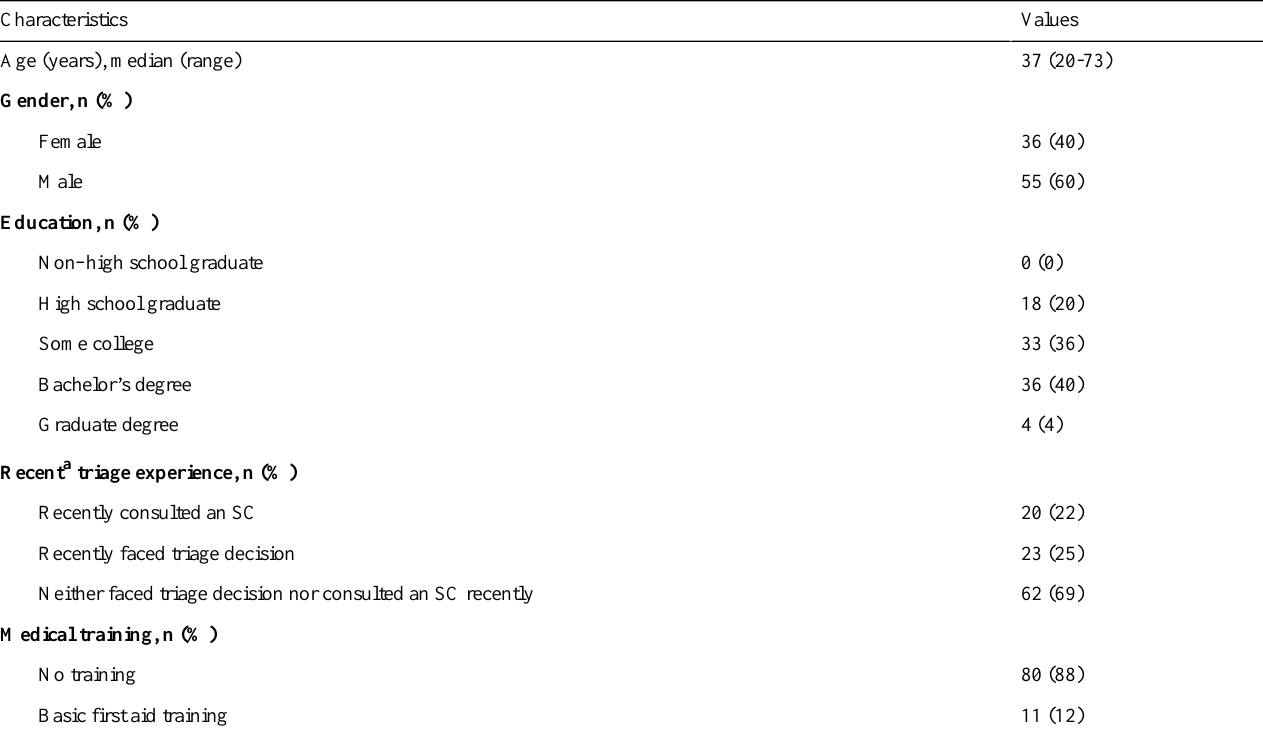
Table 1. Participant characteristics